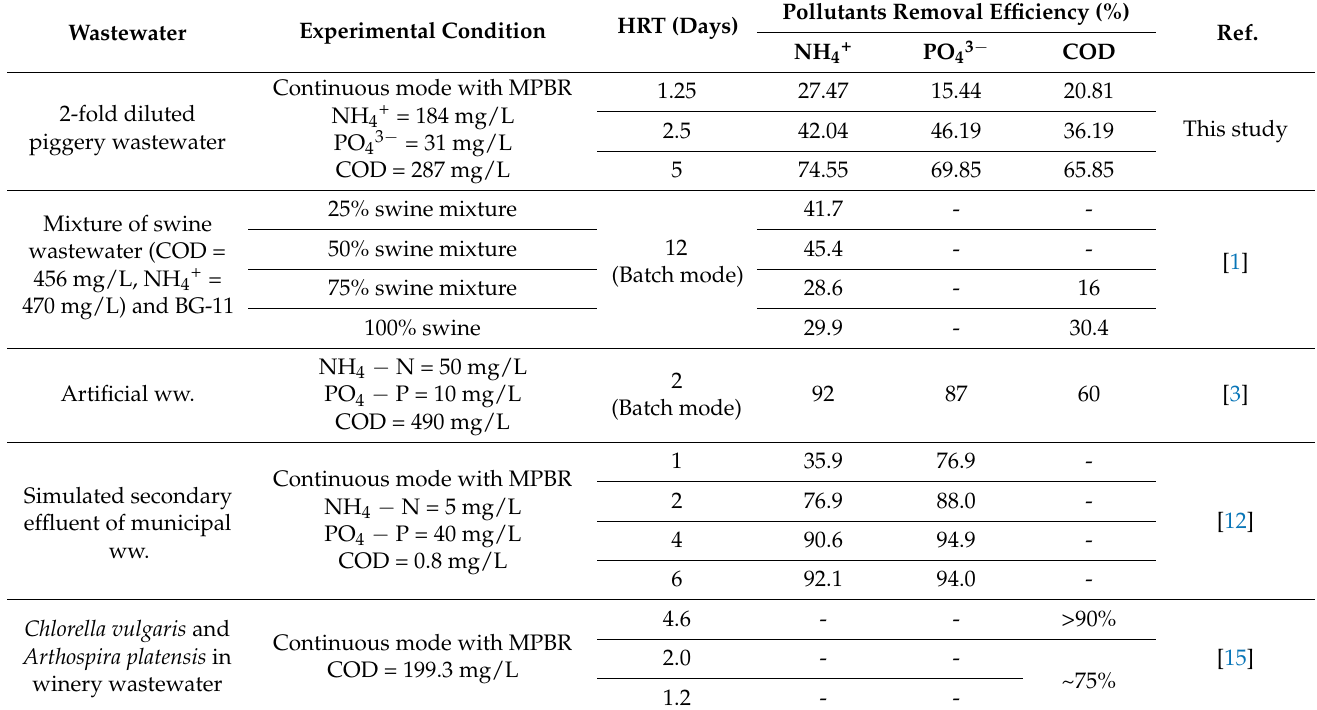
Table 4. Pollutants removal efficiency from 2-fold diluted piggery wastewater of Chlorella vulgaris - based MPBR and comparison with other